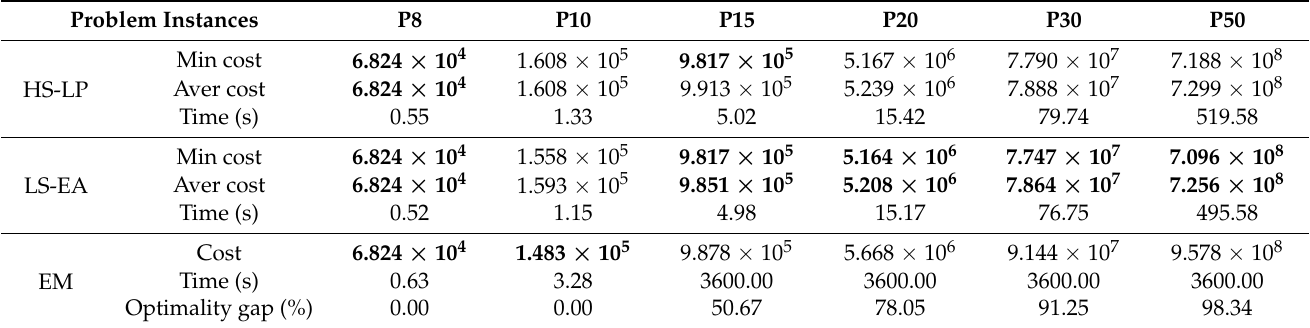
Table 3. Results of all problem